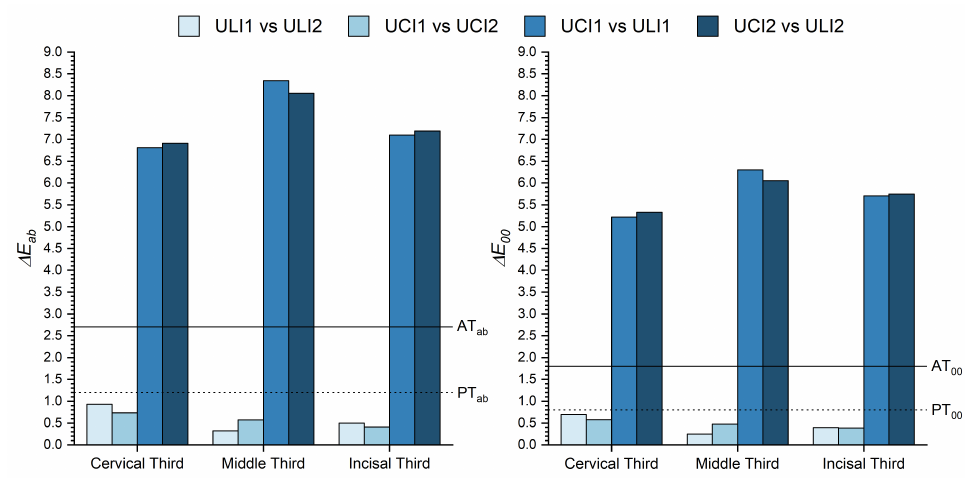
Figure 4. ∆ E ∗ and ∆ E 00 color differences between the cervical, middel and incisal thirds of contralat- ab eral and adjacent incisors.